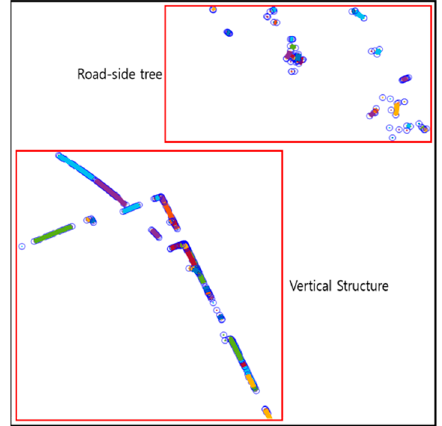
Figure 8. Result of line fitting using iterative-end-point-fit (IEPF) algorithm.